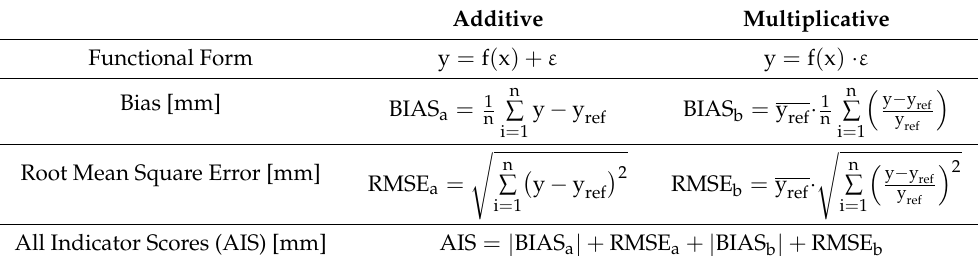
Table 1. Definition of errors in LUME based on their possible propagation in additive or multiplicative error